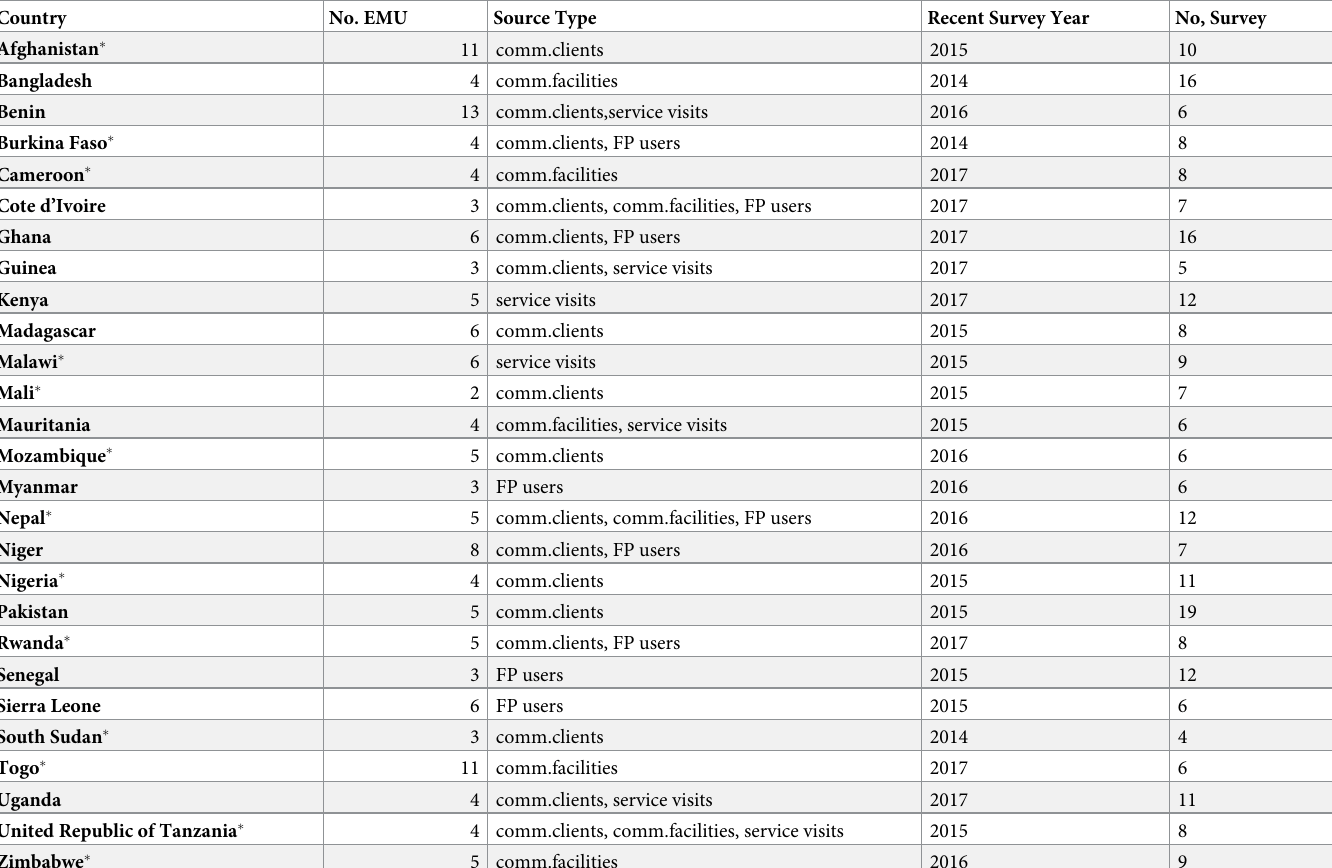
Table 1. A summary of 2018 EMU database. The first column contains the country name with the � indicating if the country used EMU data in the FP2020 2018 report. Column 2 is the number of years of available EMU data, column 3 is the service statistics source type(s) available in that country, column 4 indicates the year of the most recent survey in the 2018 survey database and column 5 is the number of survey observations available up to and including the recent survey year. Country No. EMU Source Type Recent Survey Year No, Survey 11